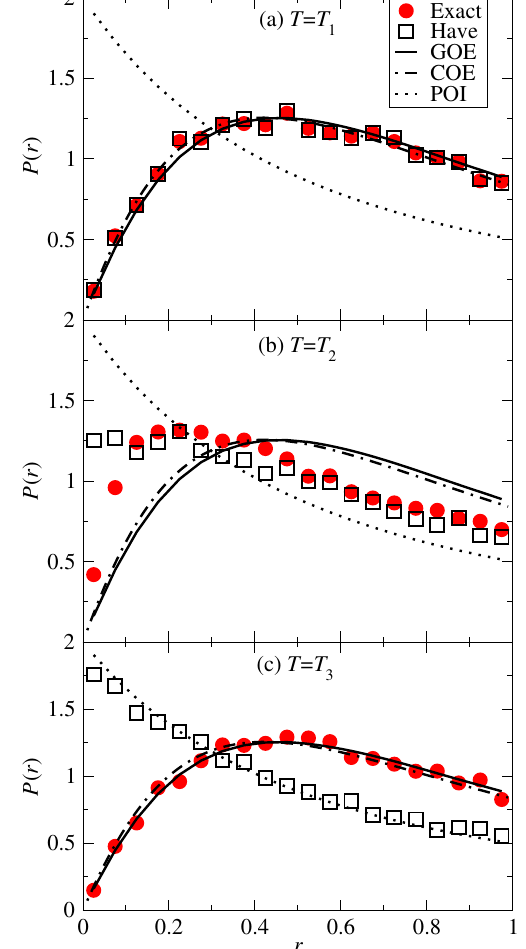
FIG. 3. Distribution P ð r Þ for the periods T ¼ T 1 , T 2 , and T 3 shown in Fig. 2. We compare the exact phases obtained from the exact diagonalization of the phases one obtains if the GOE, COE, and POI predictions